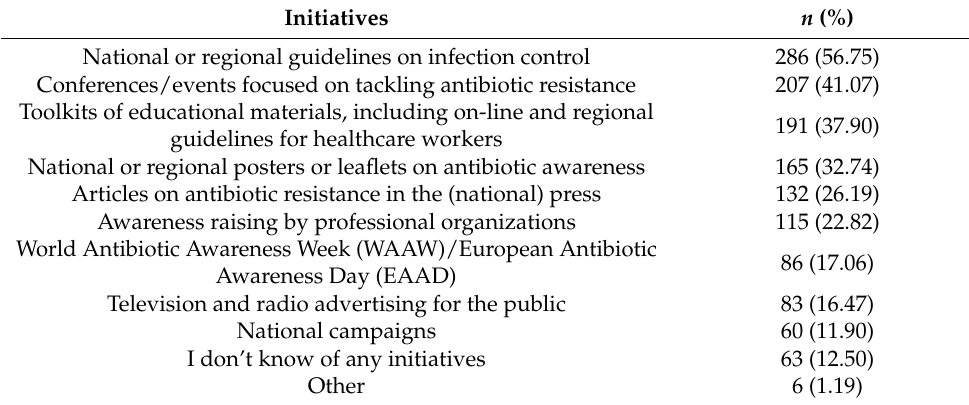
Table 5. Initiatives undertaken in Poland focusing on antibiotic awareness and antibiotic resistance ( n = 504).